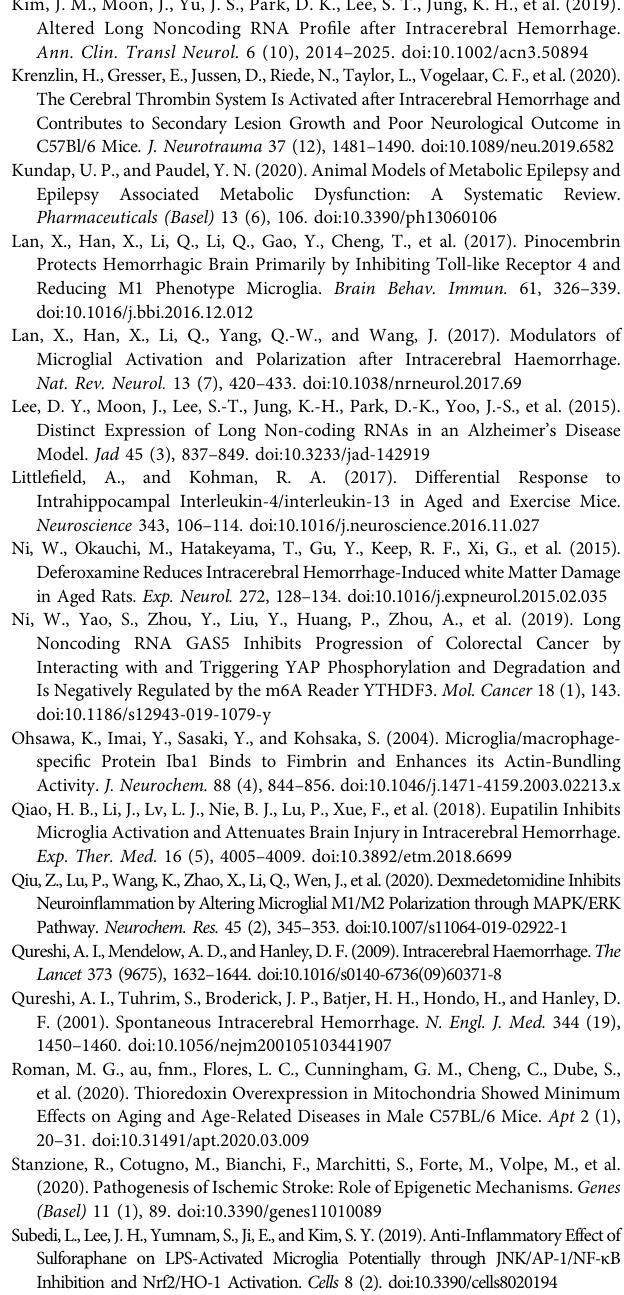
Supplementary Figure S4 | Impact of TCONS_00145741 on the activation of microglia in ICH. (A and B) 72 h after the construction of the mouse ICH model, the activation of mouse microglia was assessed by immuno fl uorescence (Scale bar (cid:2) 50 μ m). * P < 0.05, ** P < 0.01 vs. vehicle. Supplementary Figure S5 | The mechanism of TCONS_00145741 mediates the pathological process of ICH. Under ICH pathological conditions, the expression of TCONS_00145741 was elevated after thrombin treatment of microglia, and the highly expressed TCONS_00145741 elevated JNK phosphorylation levels by restraining the binding of DUSP6 and JNK, which in turn led to the secretion of pro-in fl ammatory factors and the differentiation of microglia from M0 to M1, and further imbalanced M1/M2 to eventually aggravate